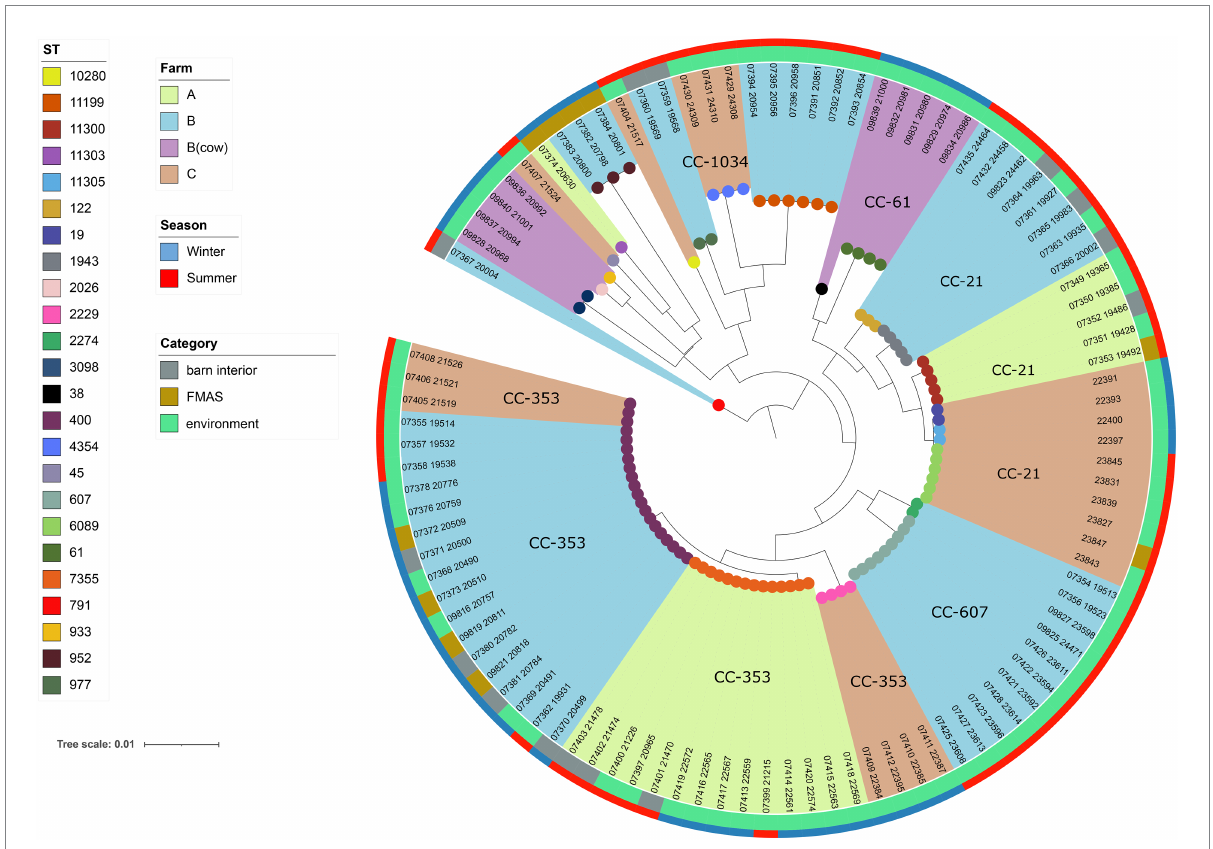
FIGURE 4 Maximum-likelihood phylogenetic tree based on the alignment of 99 C. jejuni core genomes (1,234 genes) using roary v3.12.070 and RAxML. The phylogenetic tree was visualized using iTOL v6 and rooted at the midpoint. Brown, light blue and light green shades display the different broiler farms. Clonal Complexes (CC) are indicated. Sequence types (STs) are displayed at the leaf node. The outer ring represents the season while the inner ring displays isolate category (FMAS, barn interior or